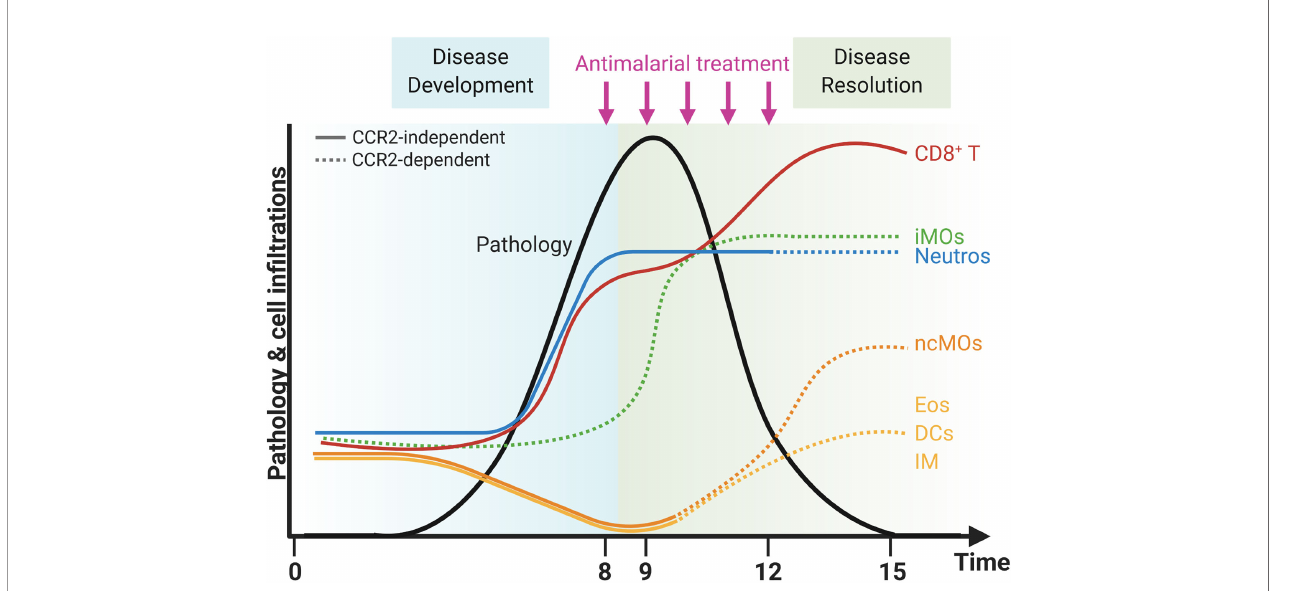
FIGURE 10 | CCR2-dependent dynamics of pulmonary leukocytes during in fl ammation and resolution. Upon infection with Pb NK65 parasites, C57BL/6 mice develop malaria-associated acute respiratory distress syndrome (MA-ARDS). This development of pathology is accompanied by an increase in the number of neutrophils (Neutros) and pathogenic CD8 + T cells and a decrease in the number of eosinophils (Eos), dendritic cells (DCs), interstitial macrophages (IM), and non- classical Ly6C − monocytes (ncMOs) in the lungs. Late in the development of MA-ARDS, the number of pulmonary in fl ammatory Ly6C + monocytes (iMOs) increased as well. Upon antimalarial treatment, mice recover from MA-ARDS with a decrease in clinical symptoms and lung pathology. During resolution, the number of CD8 + T cells further increased in the lungs, whereas the number of Neutros and iMOs remained high. In addition, the Eos, DCs, and IM reappeared in the lungs and the ncMOs increased even higher than in control mice during resolution. CCR2 gene KO inhibited several of these dynamic changes, and CCR2-dependent effects were indicated with dashed lines. The number of iMOs present in the lungs was decreased at each time-point in the CCR2 KO mice. In addition, the Neutros remained high during resolution in CCR2 WT mice, but decreased in the CCR2 KO mice. The Eos, DCs, IM, and ncMOs did not reappear or increase during resolution in the lungs of CCR2 KO mice. Created with